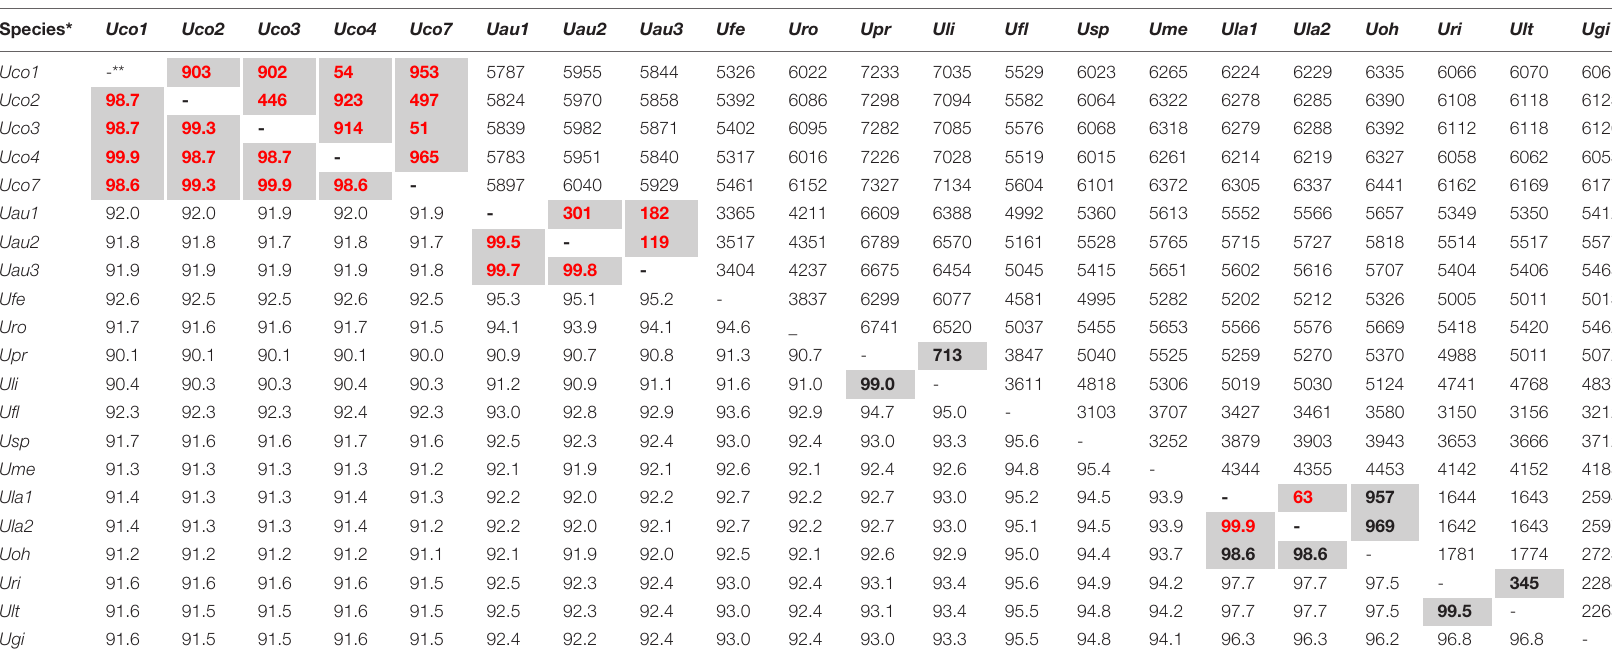
TABLE 5 | Differences (bp, upper-right) and identity values (%, bottom-left) of the aligned nucleotide (nt) sequences of 100 common genes (71 PCGs, 3 rRNAs, and 26 tRNAs) from 21 complete chloroplast genomes of Ulva species.